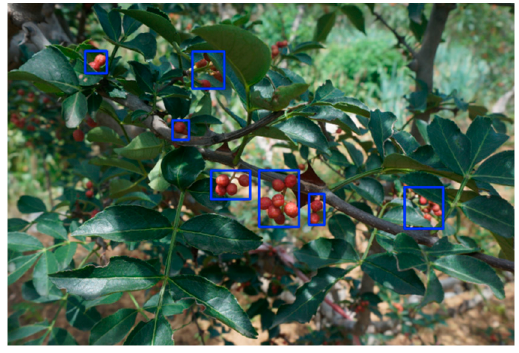
Figure 2. Sample image annotation.